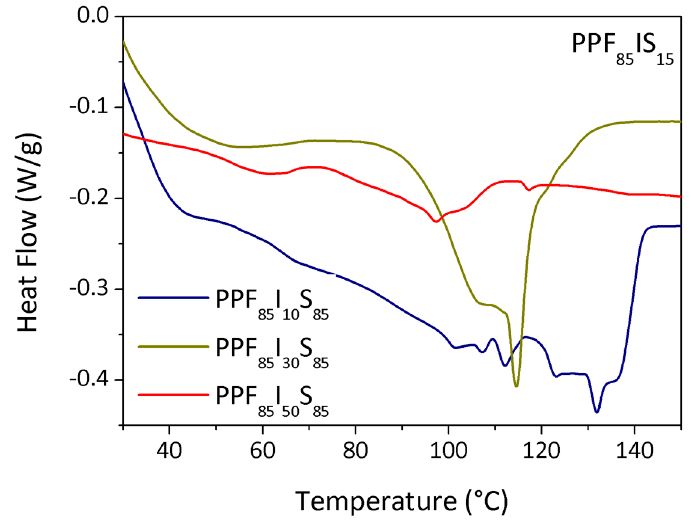
Figure 7. First heating scan at 10 °C/min for polyesters PPF 85 I 10 S 15 , PPF 85 I 30 S 15, and PPF 85 I 50 S 15 .